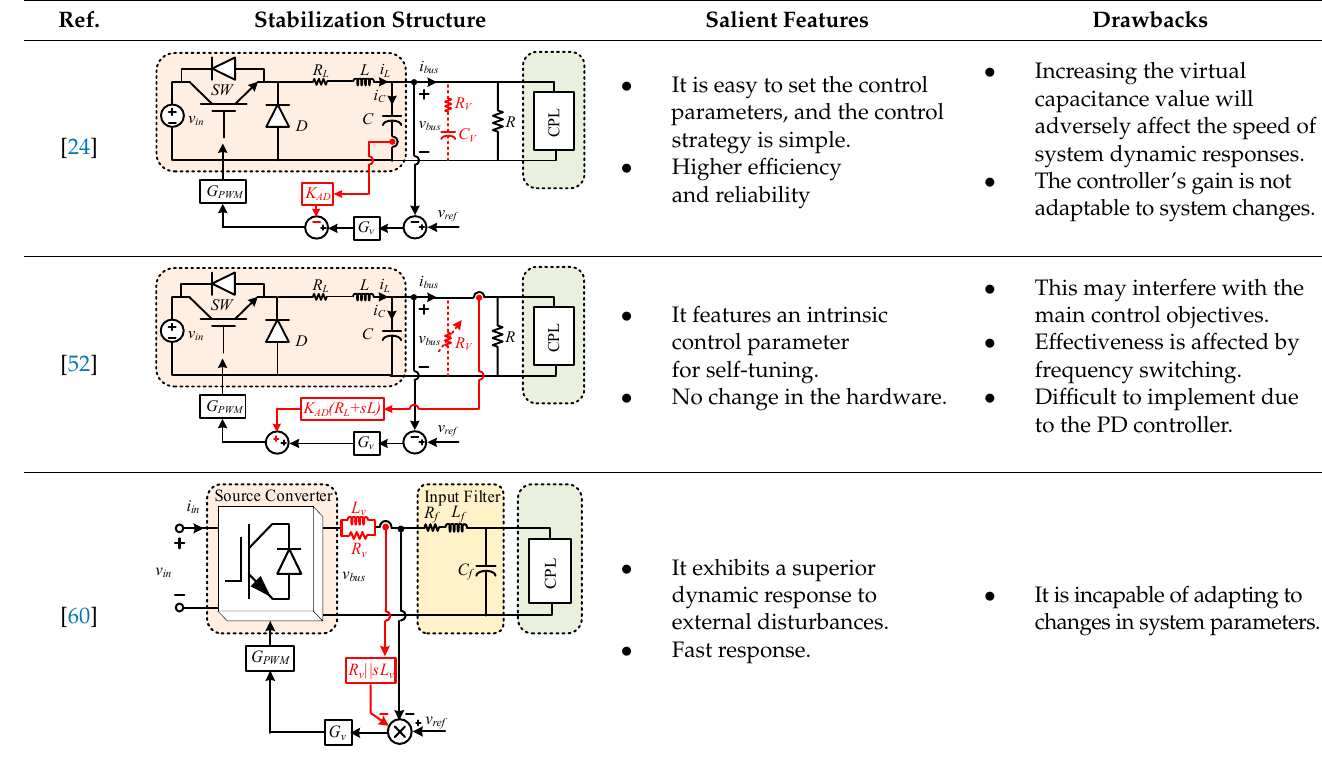
Table 1. Summary of source-side CPL compensation techniques. Ref.